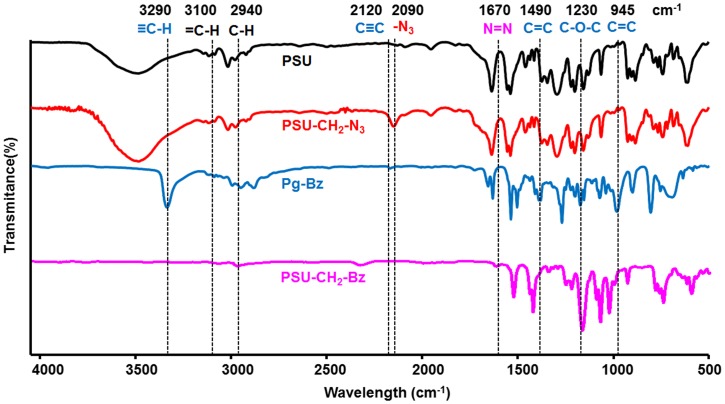
FT-IR spectra of PSU, PSU–CH2–N3, Pg–Bz, and PSU–CH2–Bz compounds.